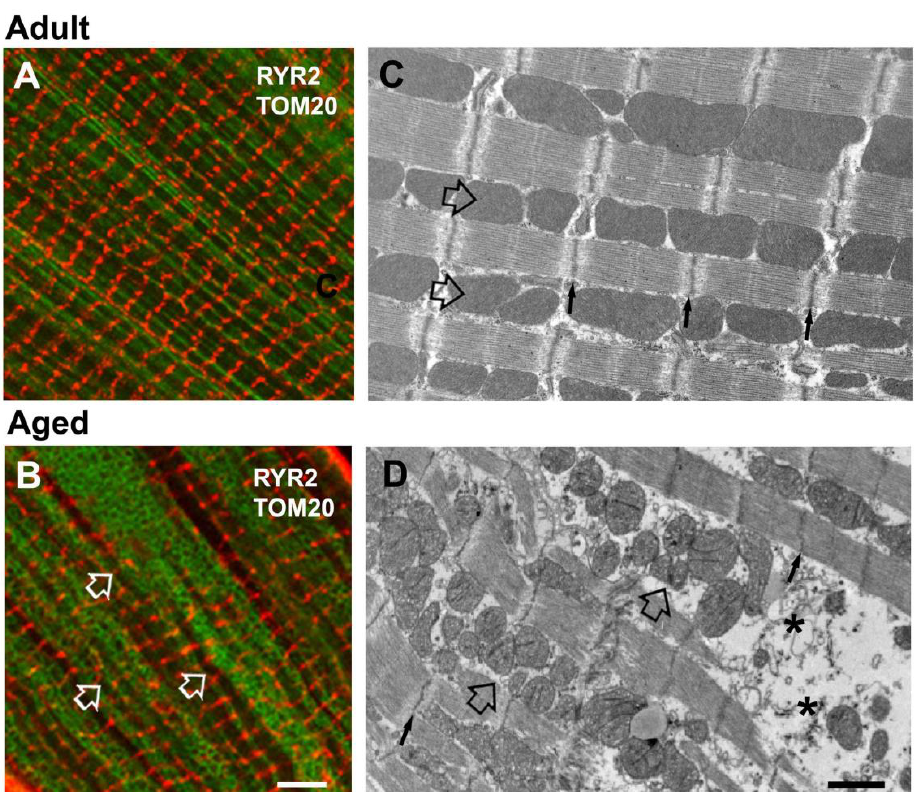
Figure 1. Representative confocal and electron images of cardiomyocytes. ( A , B ) CM images of adult and aged cardio- myocytes double-immunolabeled for mitochondria (in green, TOM20), pointed by white empty arrows in B, and RYR2 (in red). See also Supplementary Figure S1. ( C , D ) EM images of mitochondria (pointed by black empty arrows) disposed in longitudinal columns between myofibrils in adult and abnormally clustered in aged cardiomyocytes. Asterisks in panel D point to apparently empty cytoplasmic space. Scale bars: ( A , B ), 5 μm; ( C , D ), 1.0 μm. The different immunostaining pattern in aged sample may be the result of the morphological alterations revealed by EM ultrastructural analysis (Figure 1C,D). In adult